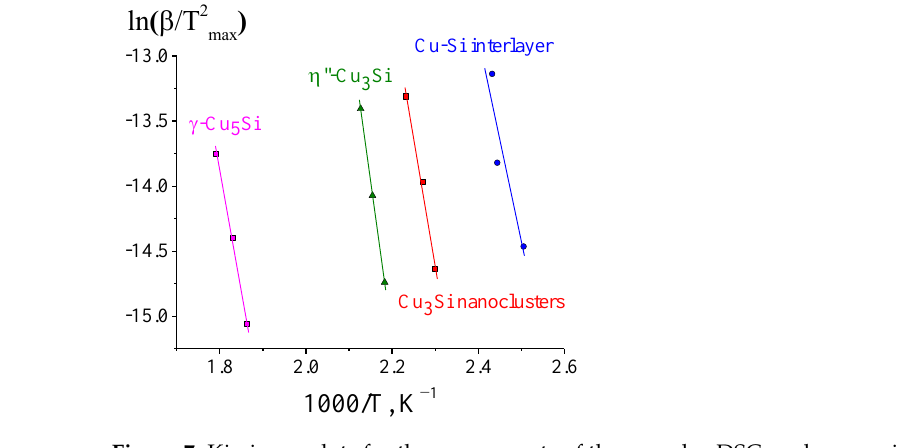
Figure 7. Kissinger plots for the components of the complex DSC peak appearing during the solid-state reaction in the (Cu/a-Si) 30 multilayer films. Table 5. Kinetic parameters for the phase formation during solid-state reaction in the Cu/a-Si bilayer films based on the Kissinger analysis of DSC data.